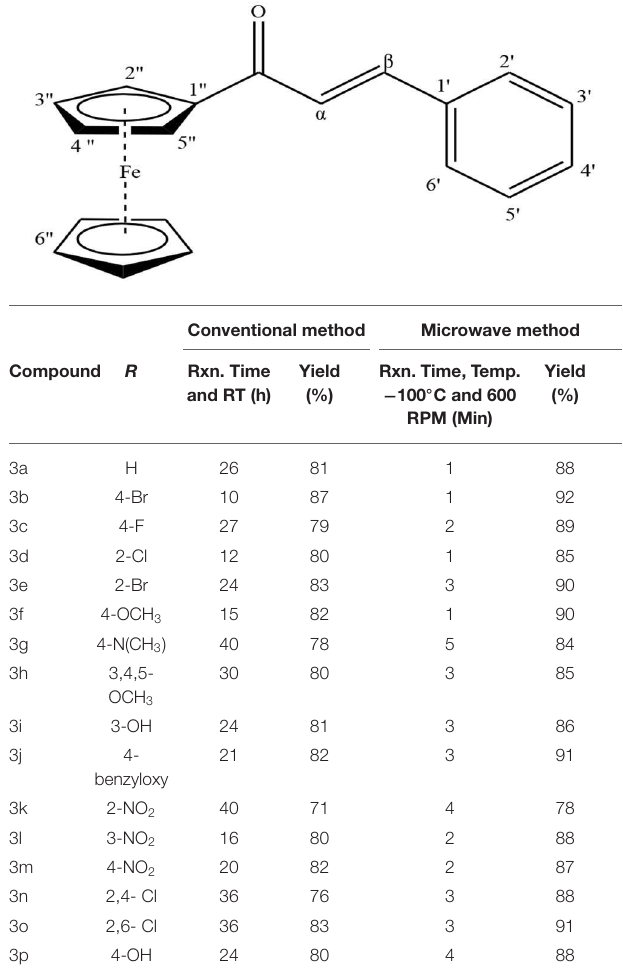
TABLE 1 | Comparison of reaction time and yield (%) of Microwave (MM) and Conventional